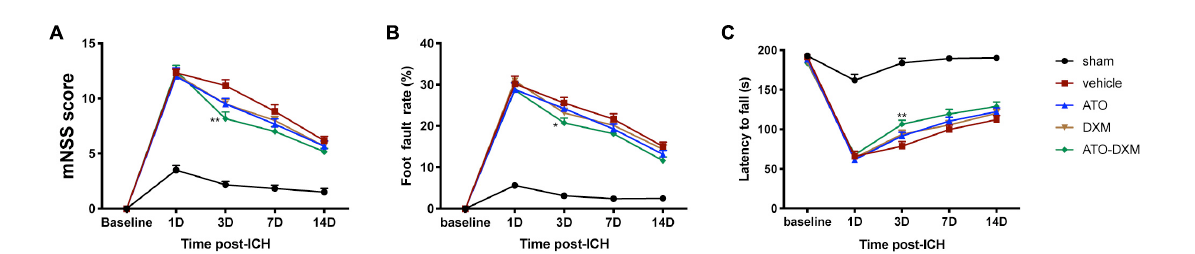
FIGURE3 Neurological functional evaluations. (A) mNSS after ICH; (B) foot-fault test after ICH; (C) Rota-rod test after ICH. * p < 0.05, ** p < 0.01 vs vehicle group.